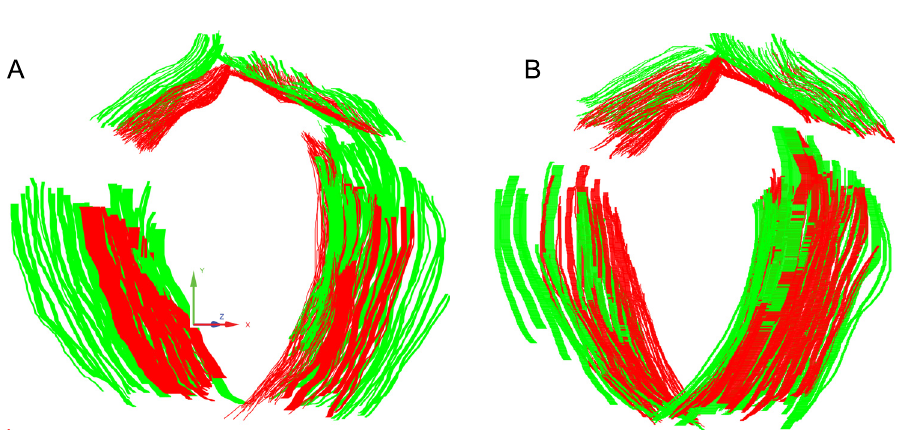
Fig 8. Comparison of pubic bone and levator ani muscles boundaries (A) before and (B) after applying M3VR. Green: boundaries from fixed ultrasound volume; red: boundaries from moving ultrasound volume.